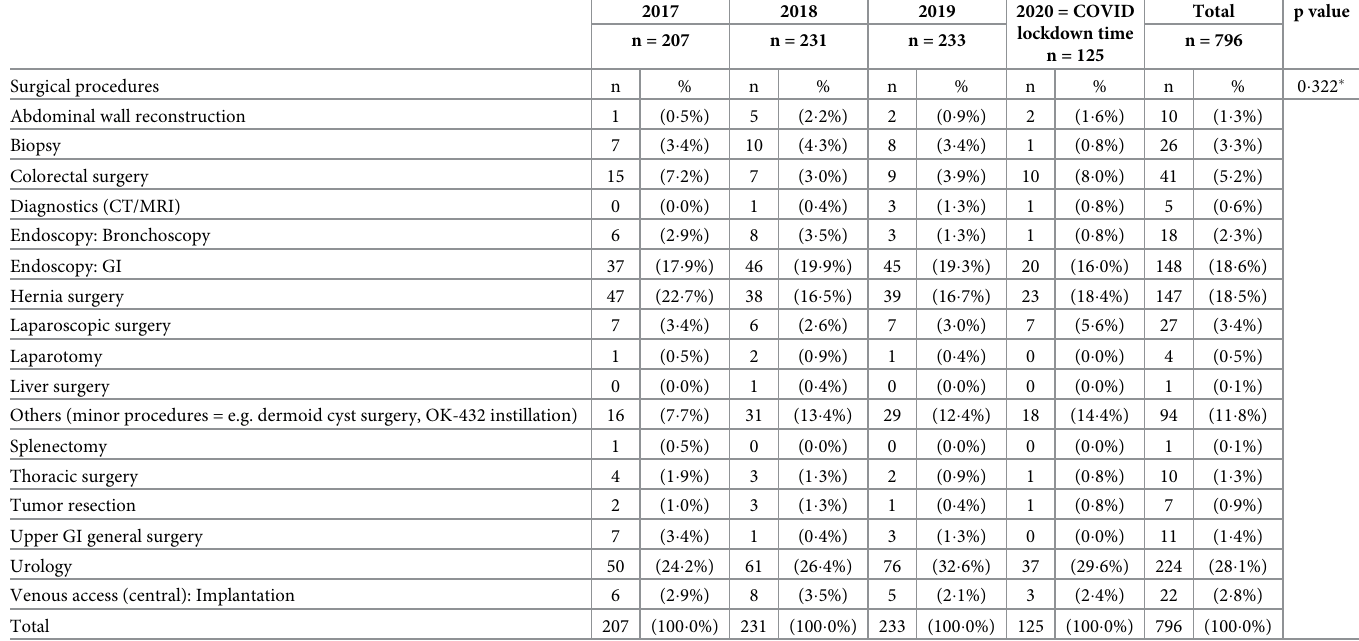
Table 2. Types of